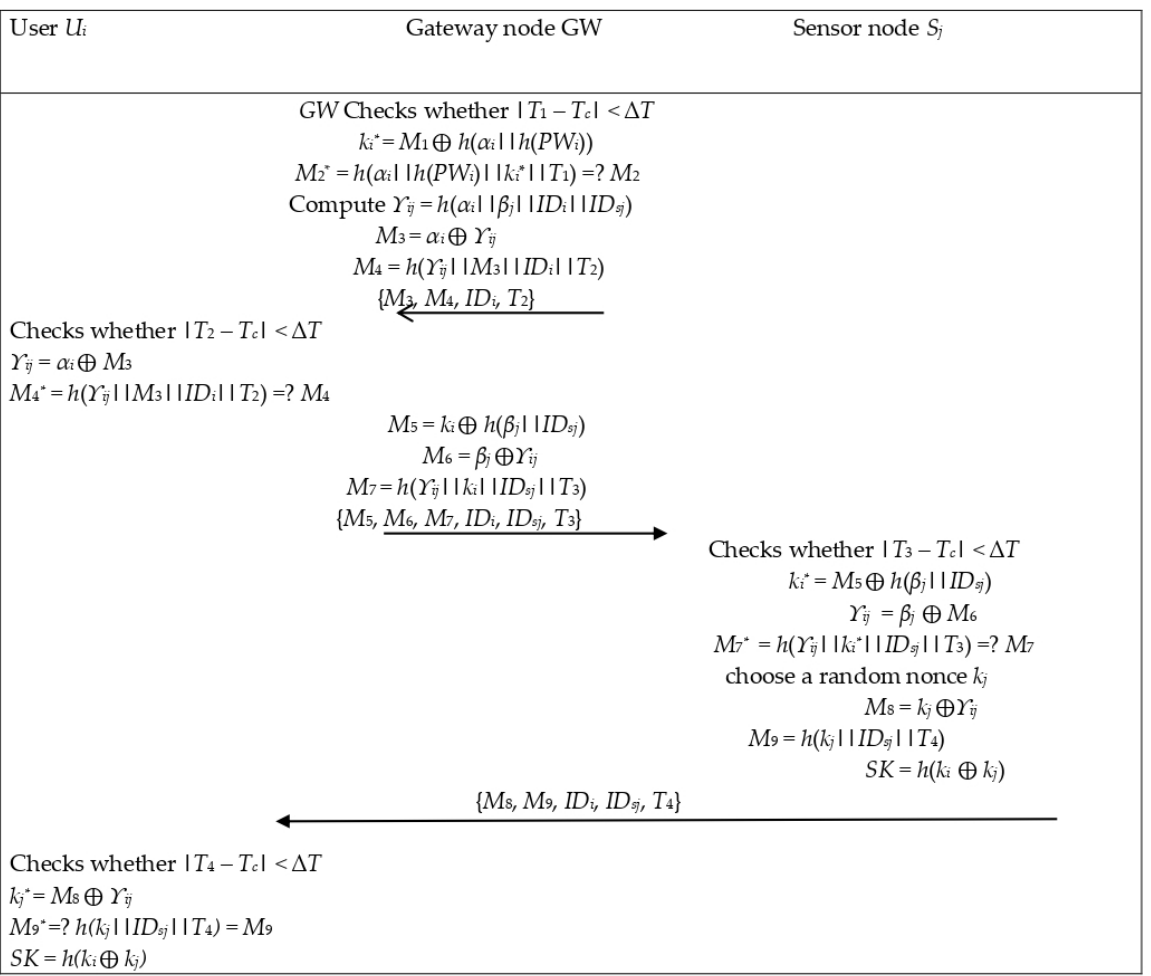
Figure 4. Authentication phase of Singh et al.’s scheme.